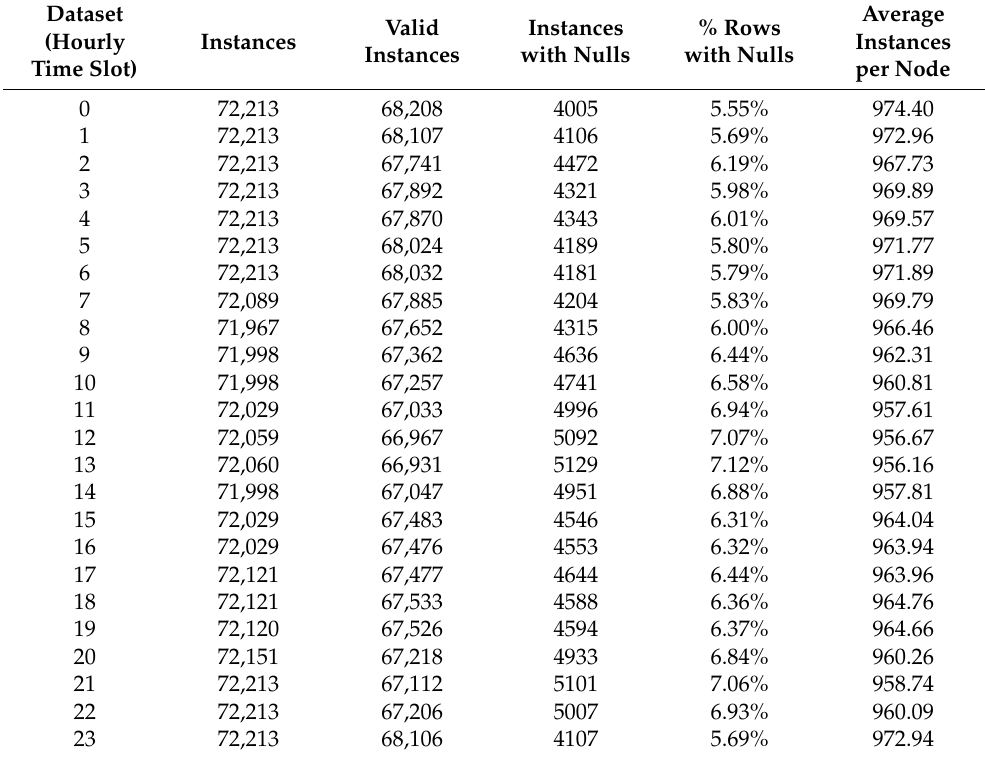
Table 2. Hourly sound pressure level datasets.